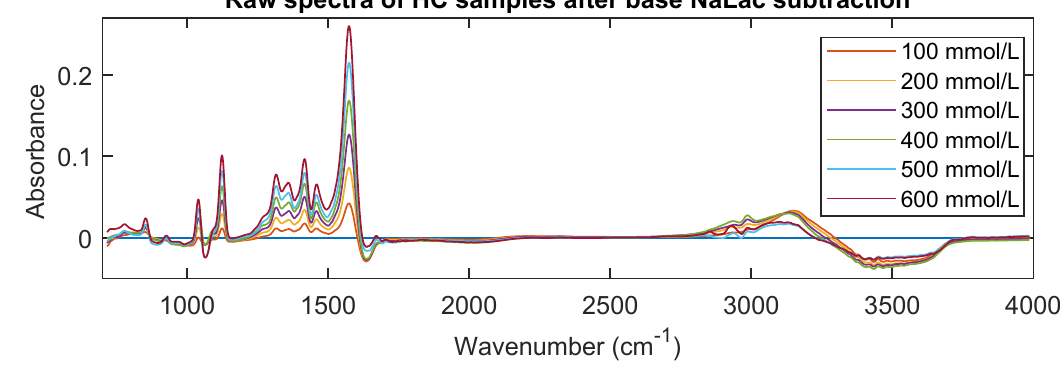
Figure 7. MIR spectra of high concentration samples after base NaLac subtraction. The absorption in each spectrum at the identified peaks linearly proportional to concentration.